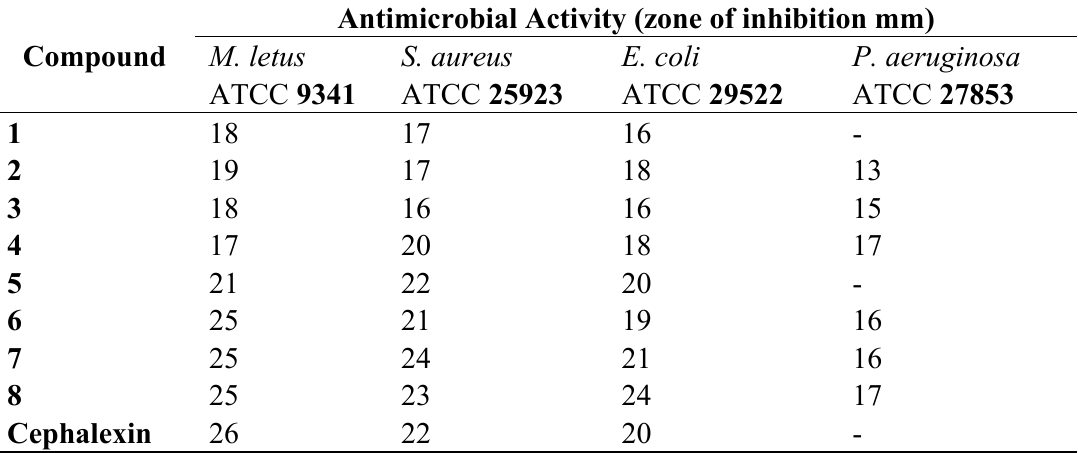
Table 1. Antimicrobial activities of the newly synthesized